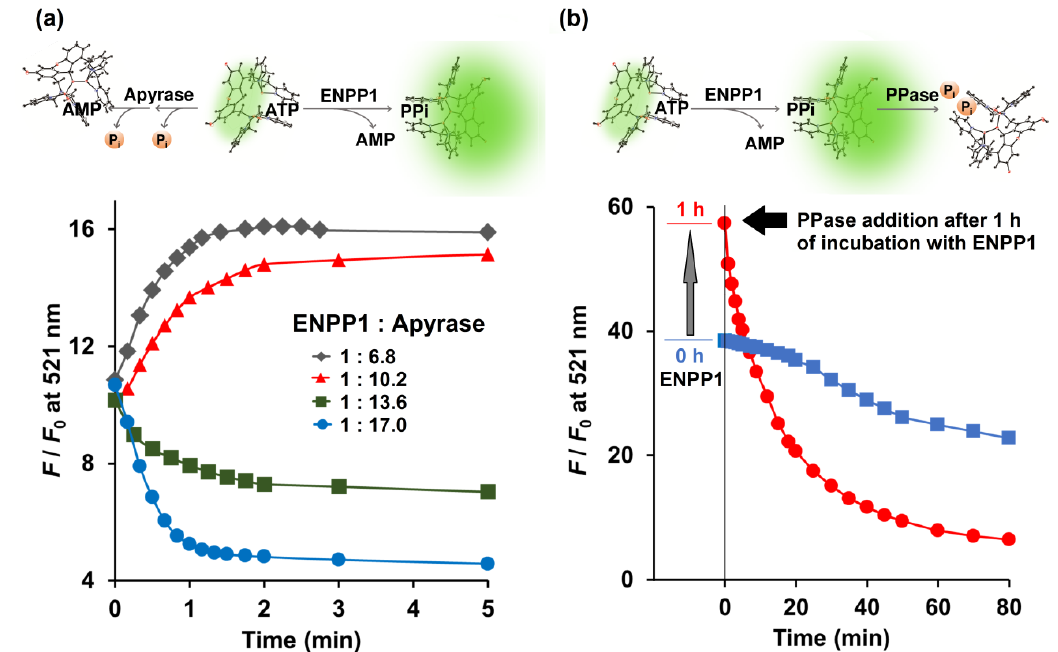
Figure 3. ( a ) Competitive catalytic activity of ENPP1 (0.734 ng/ μ L) and apyrase (5.0, 7.5, 10.0 and 12.5 ng/ μ L) toward 5 μ M ATP monitored in real time by 1 μ M Kyoto Green; ( b ) Catalytic activity of ENPP1 (1.1 ng/ μ L) when 50 μ M of ATP was used as a substrate. PPase (0.03 ng/ μ L) was added at 0 (blue square) and 1 h (red circle) after ENPP1 addition. Measurement conditions: 50 mM HEPES buffer, 10 mM NaCl, 1 mM MgCl 2 (pH 7.4, 25 °C, λ ex = 488 nm).